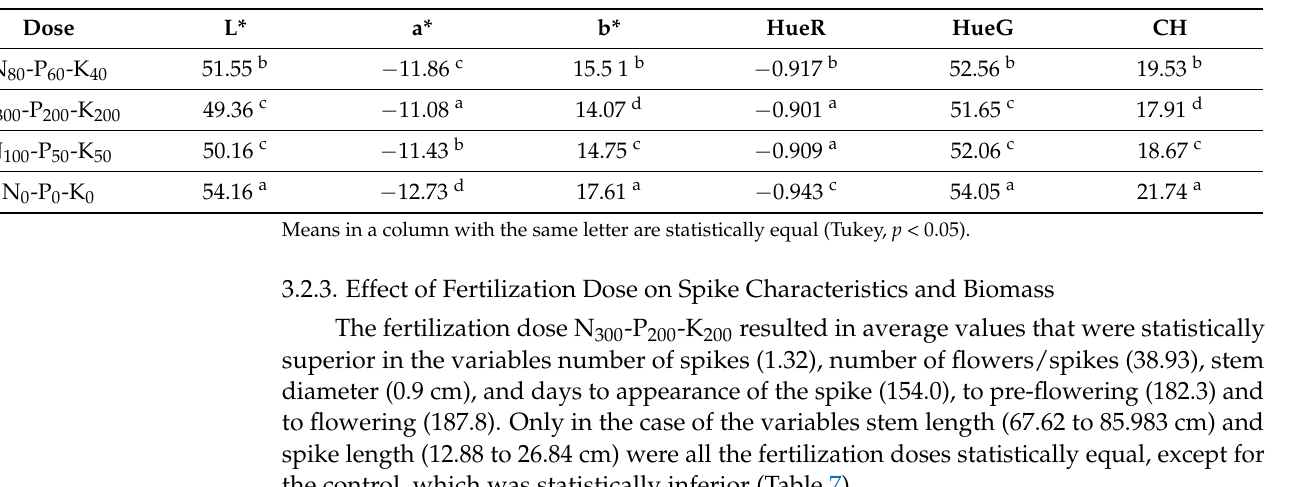
Table 6. L*, a*, b*, hue, and chroma in tuberose leaves fertilized with different doses.